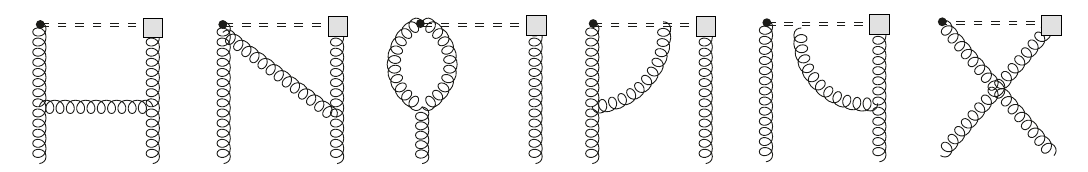
Figure 4 . The counterterm diagrams for the operator O 2 g . The shaded box stands for the ver- tex ( n (cid:22) n ) A (cid:22) (cid:0) (cid:22) n (cid:22) A + . but their sum can be simpli(cid:12)ed to the diagrams shown in lowest row. Strictly speaking, there is also a contribution of the form ( z